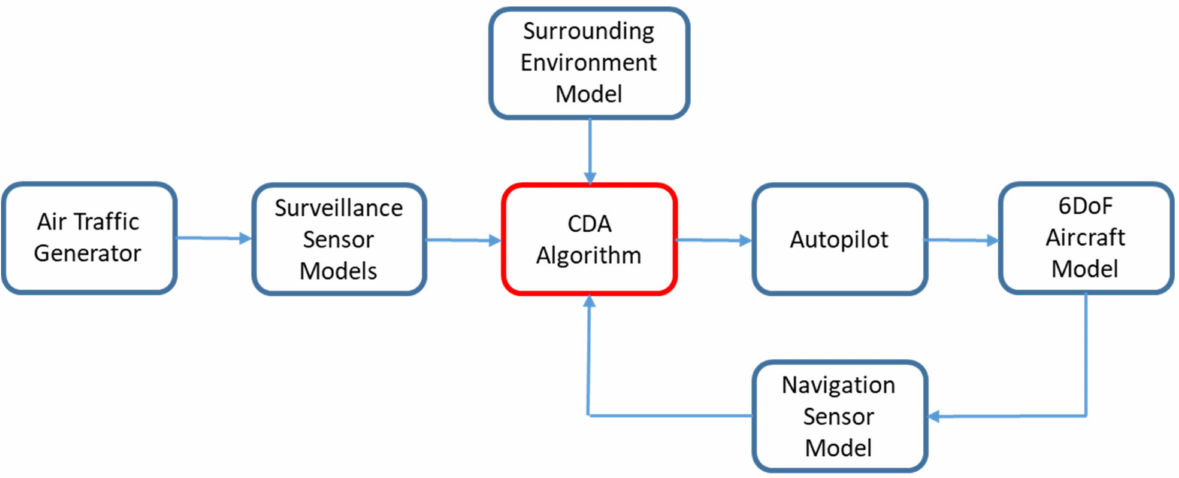
Figure 13. Interoperability with TCAS-II